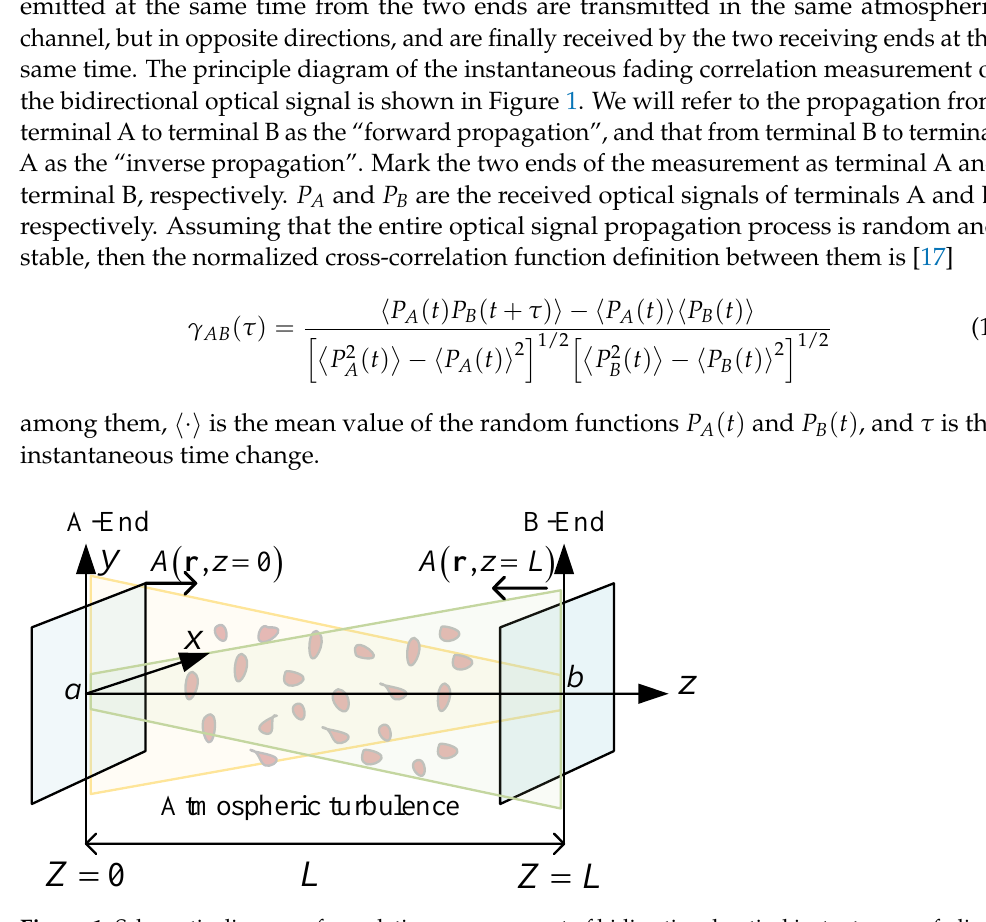
Figure 1. Schematic diagram of correlation measurement of bidirectional optical instantaneous fading.